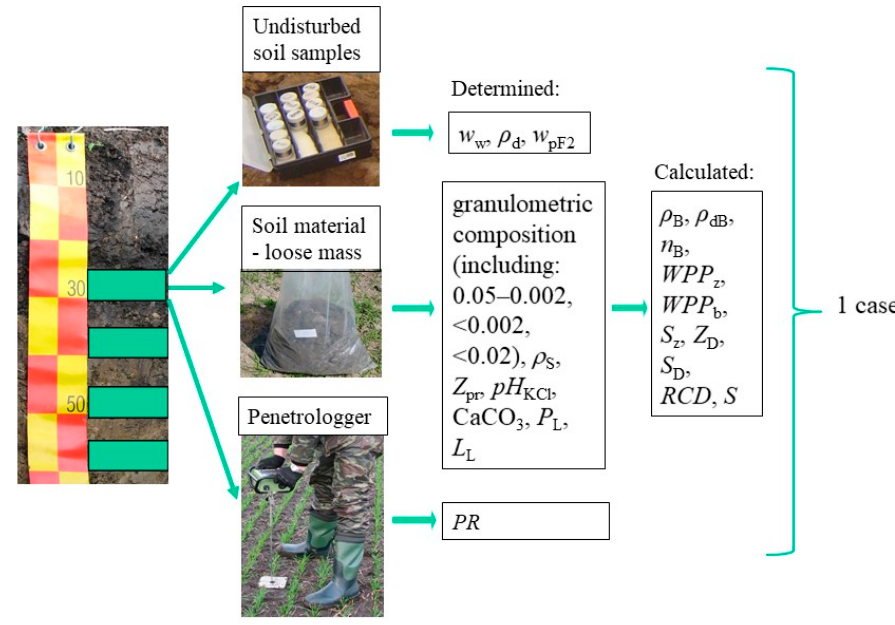
Figure 2. Scheme of creating data cases for each measurement term of the soil layer in each soil pit—an example for a 25–30 cm layer.